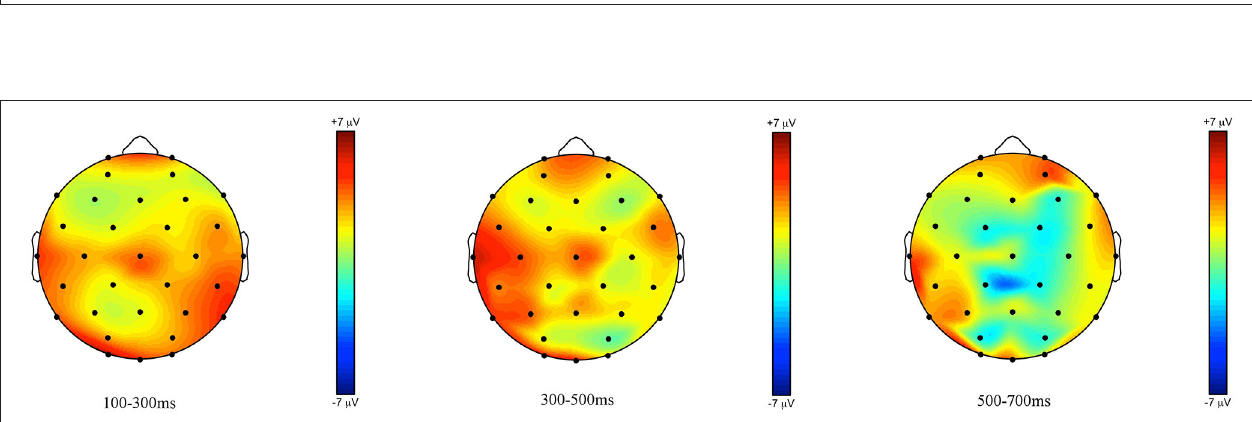
FIGURE 2 | Topographic maps of the ERPs recorded in children, time-locked to the presentation of the word “Alle” ( all ) for the some -felicitous condition minus the some -infelicitous condition in the three time windows.